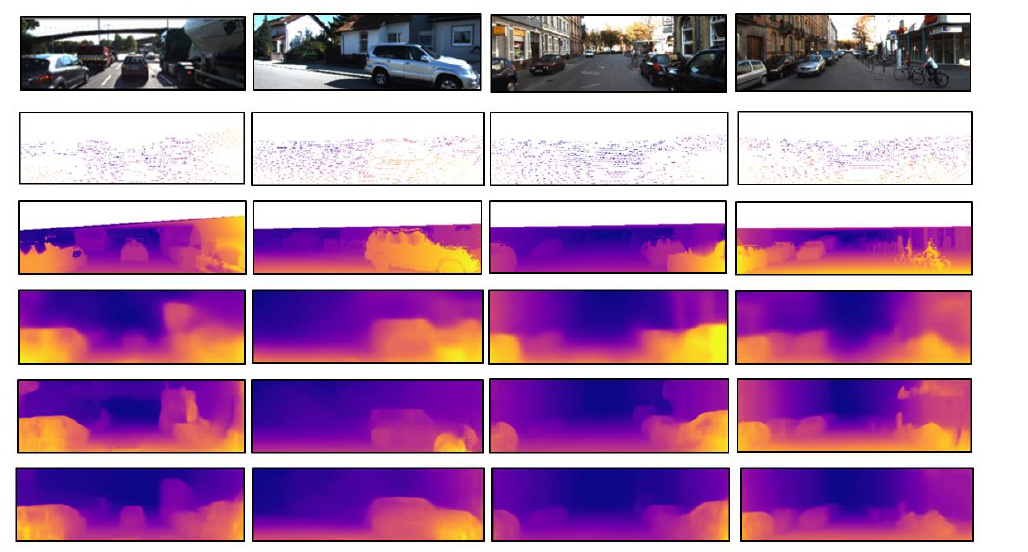
Figure 12. Qualitative results of our approach on the KITTI dataset by an Eigen split [30]. From top to bottom: input images, ground truth velodyne depth, ground truth depth by interpolation, result in [43], result in [45] and our approach.